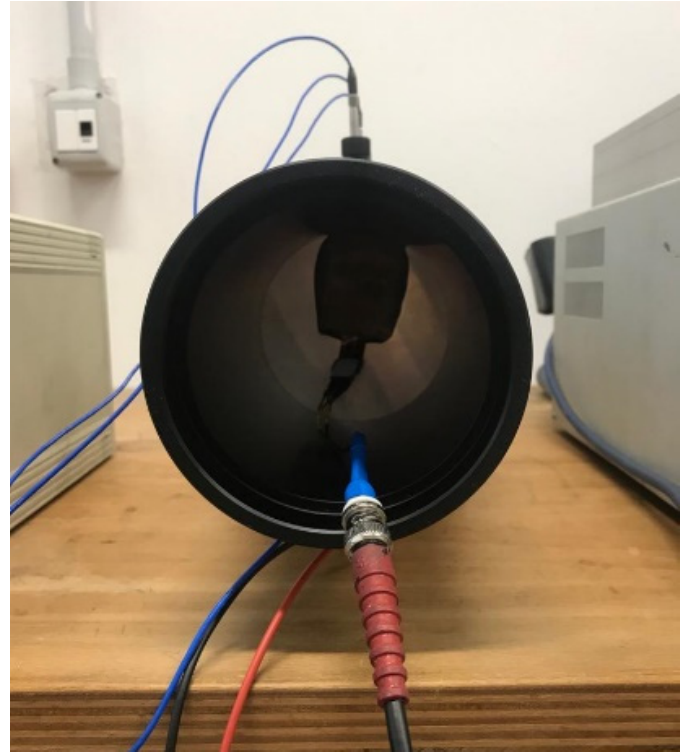
Figure 2. Active system compounded by plate and piezoelectric patch in the impedance tube and